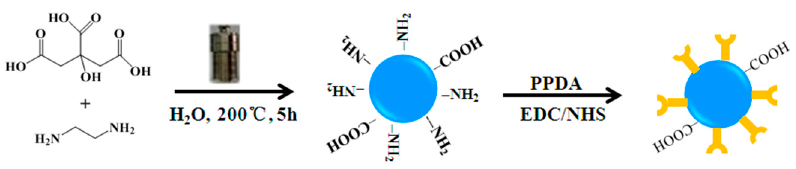
Figure 2. Schematic diagram of the preparation for FCDs.